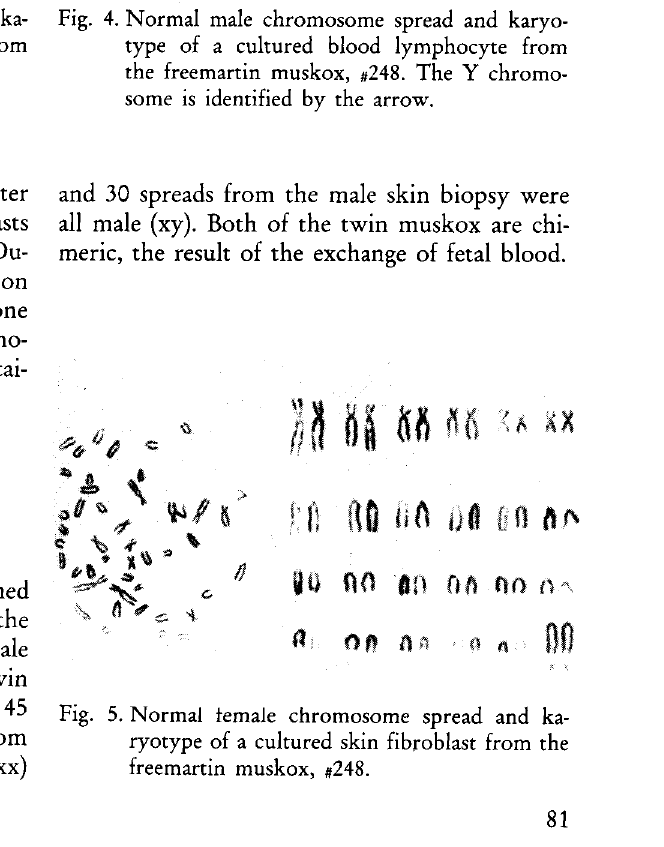
Fig. 5. Normal female chromosome spread and ka ryotype of a cultured skin fibroblast from the freemartin muskox,